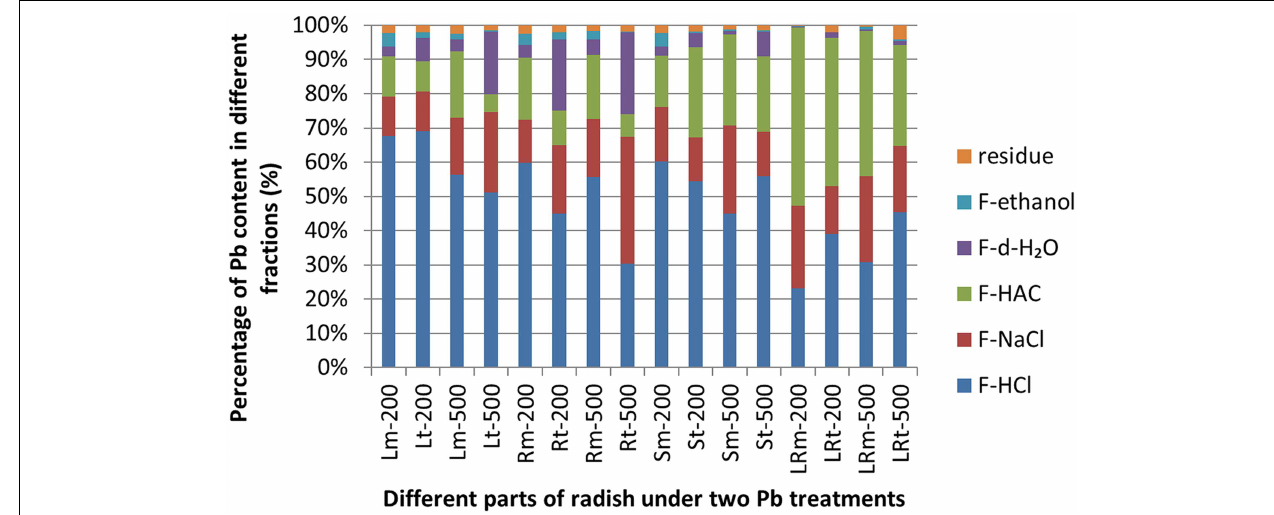
500mg/L Pb(NO 3 ) 2 . Residue represents Pb concentration in residue; F-ethanol represents ethanol-extractable form, inorganic Pb including nitrate/nitrite, chloride; F-dH 2 O extracting water-soluble Pb of organic acid and Pb(PO 4 ) 2 ; F-HAC represents HAC- extractable form, undissolved lead phosphate including PbHPO 4 and Pb 3 (PO 4 ) 2 ; F-NaCl extracting pectates, protein integrated Pb; F-HCl represents HCl- extractable form, extracting lead oxalic. All abbreviations ending with “m” refer to NAU-XLM and “t” to NAU-XHT, “R” to root and “LR’ to lateral root, “S” to skin and “L” to